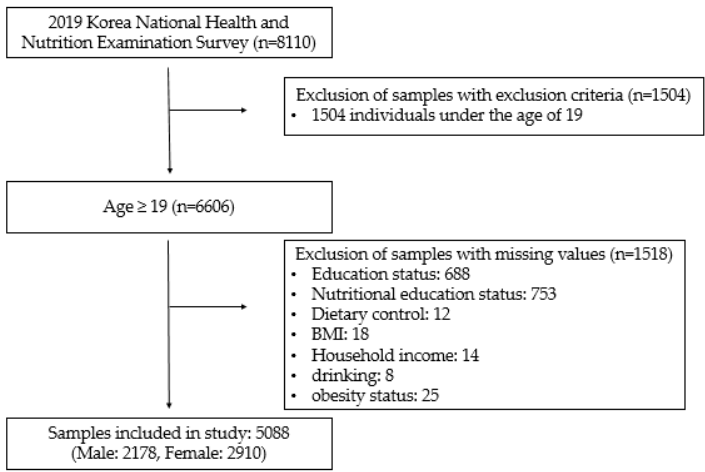
Figure 1. A schematic diagram showing the process of participant recruitment. Individuals under the age of 19 or with missing values were excluded. BMI: Body Mass Index. the age of 19 or with missing values were excluded. BMI: Body Mass